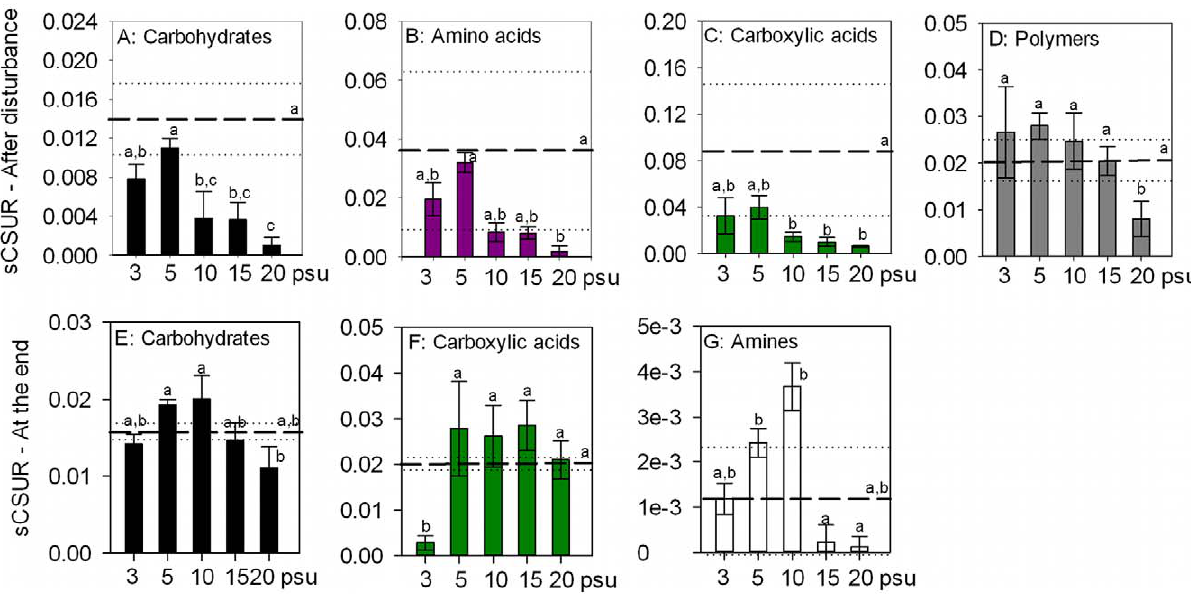
Figure 5. Changes in the average slope of significant substrate guilds in the intensity experiment (Experiment 1). Values plotted are the mean values 6 standard deviation, after the disturbance (A–D) and at the end of the experiment (E–G). Mean values of controls are represented as dashed lines (- -) and standard deviations as dotted lines ( ??? ). Tukey’s homogenous groups are represented by a, b and c.